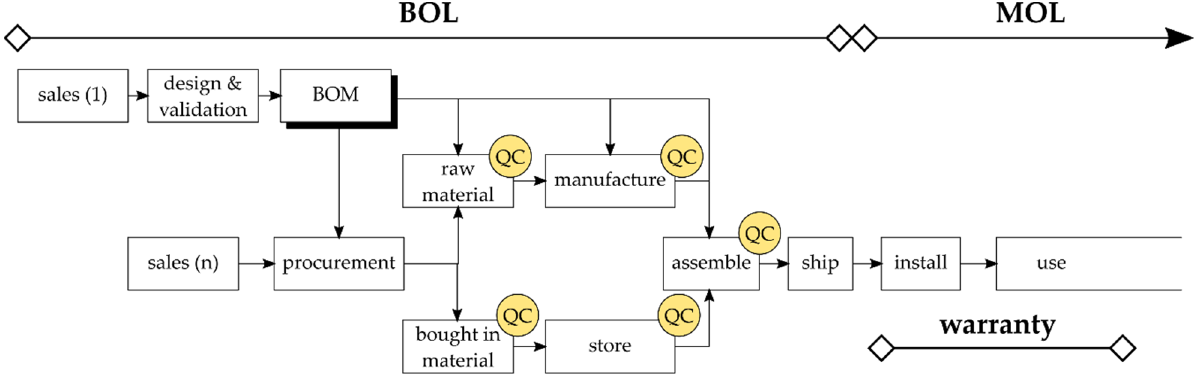
Figure 3. Information and material flows during the BOL and MOL including quality controls (QC).